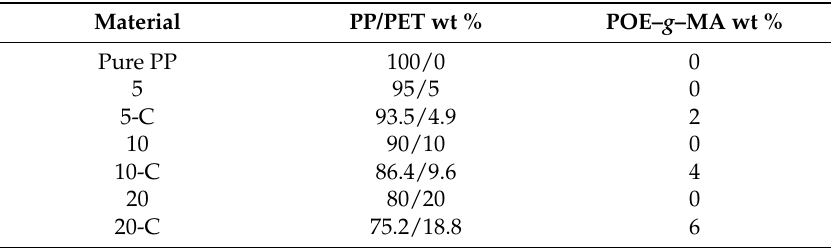
Table 1. Composition of the blends.